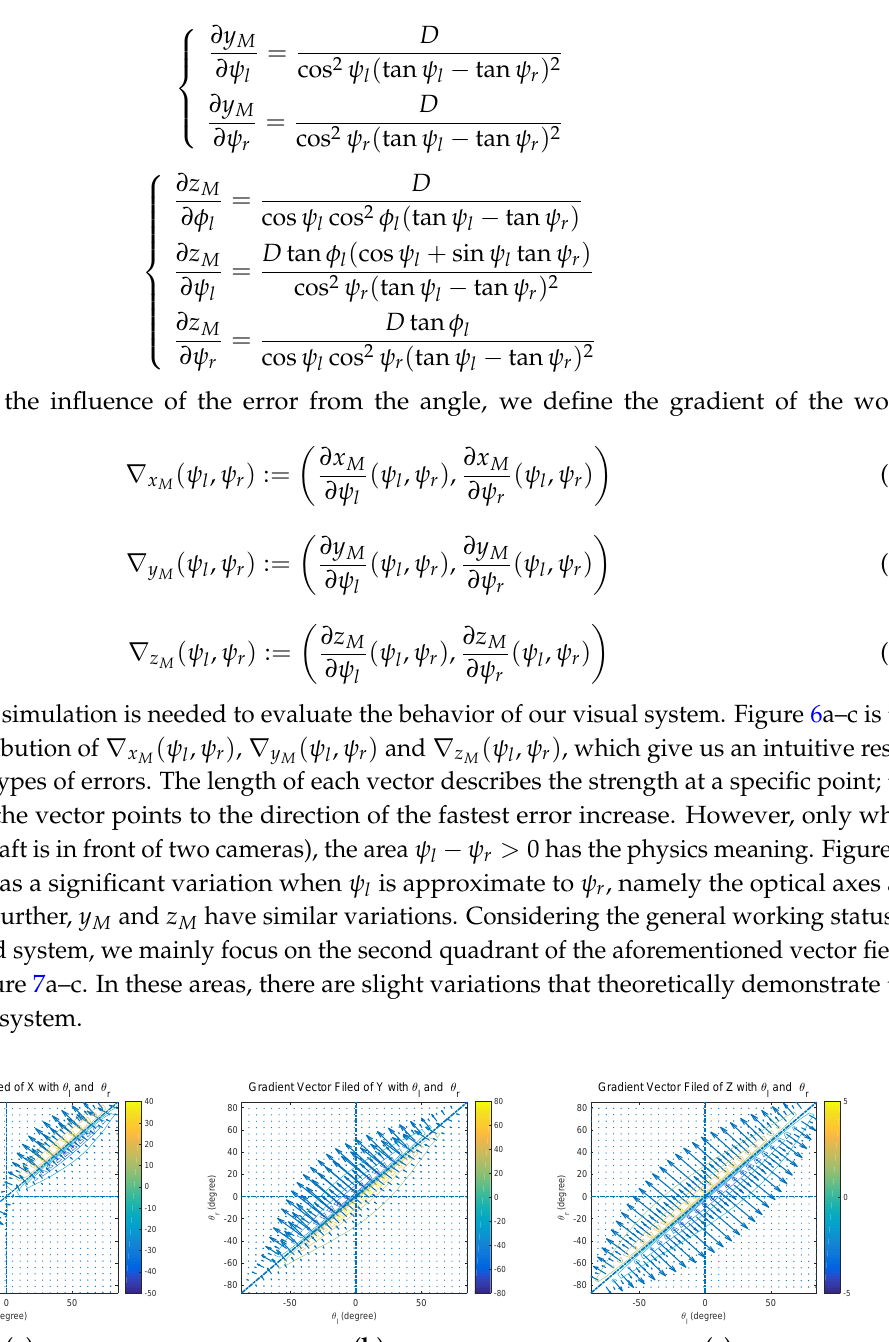
Figure 6. Vector field distribution of ( a ) ∇ x